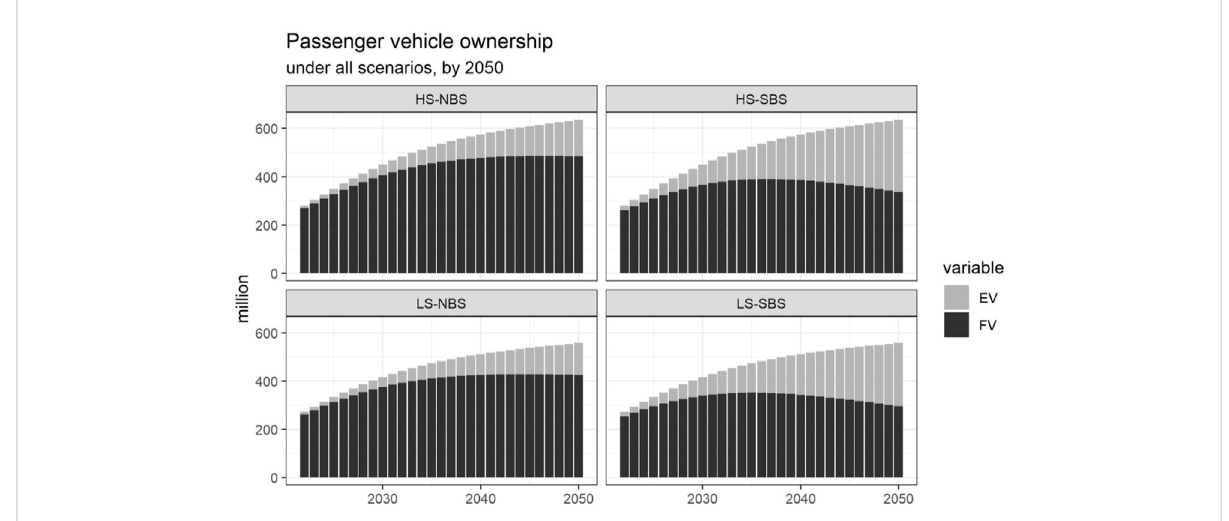
FIGURE 5 Estimation of EV and FV ownership under four scenarios from 2022 to 2050 in China. Under the four scenarios, passenger vehicle ownership continuedtorise.ThegrowthrateofthetwoscenariosunderHSishigherthanthatunderLS.FVownershipwillreachitspeakatdifferenttimepoints under the four scenarios.